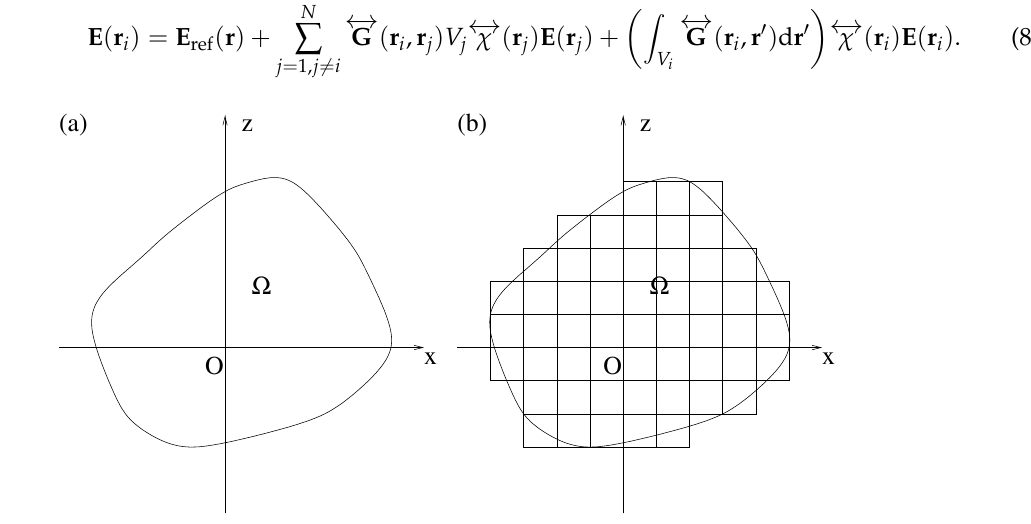
Figure 1. ( a ) Object with a support Ω in homogeneous background. ( b ) Discretization of the object with a cubic mesh for the DDA. The smaller the discretization mesh, the more the discretized object will have the shape of the studied